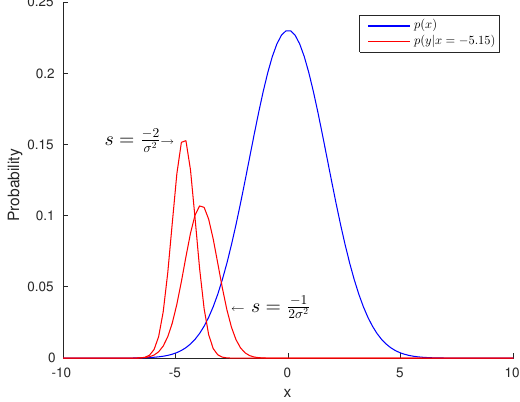
Fig. 4. Relationship between parameter s and p ( y | x